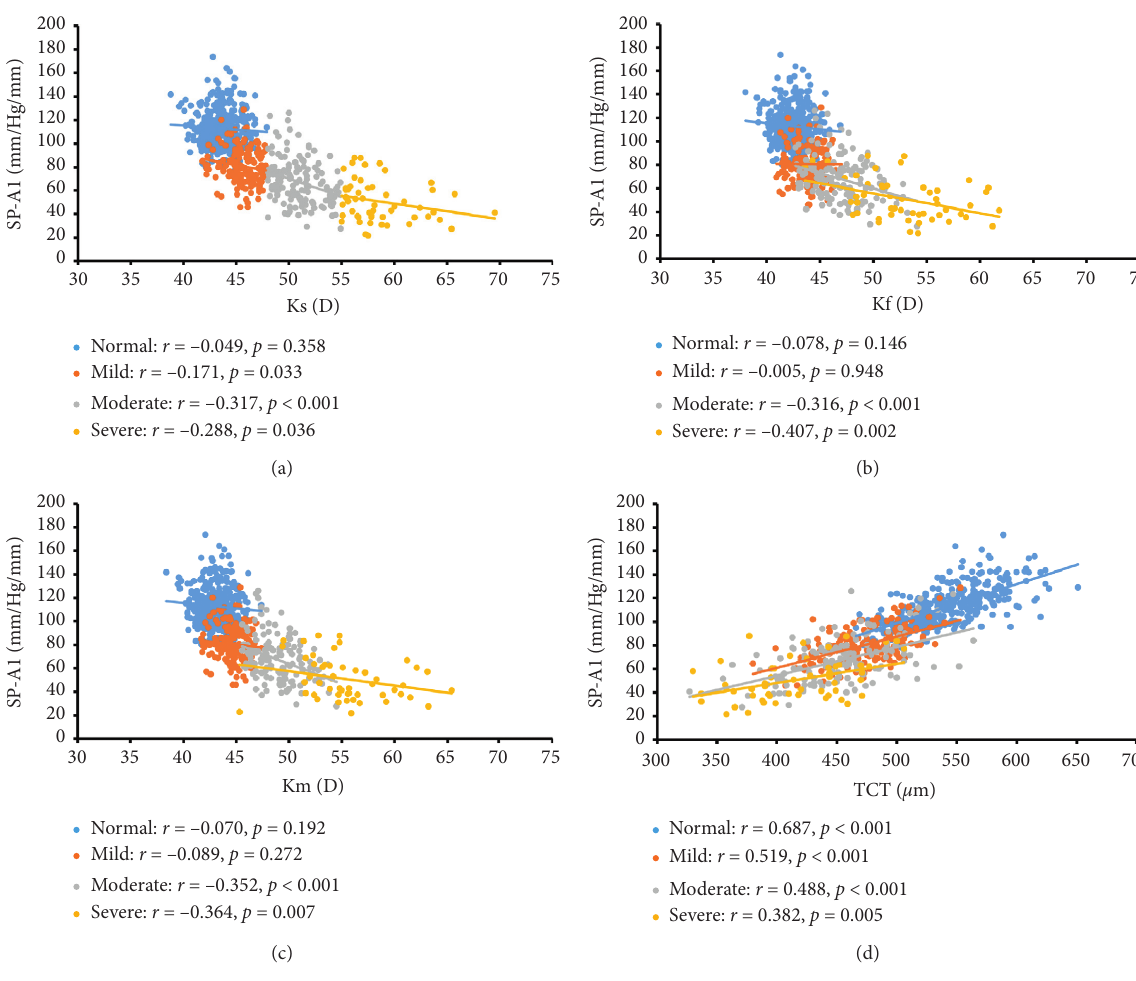
Figure 2: Association between SP-A1 and keratoconus severity. (a) Association between SP-A1 and Ks. (b) Association between SP-A1 and Kf. (c) Association between SP-A1 and Km. (d) Association between SP-A1 and